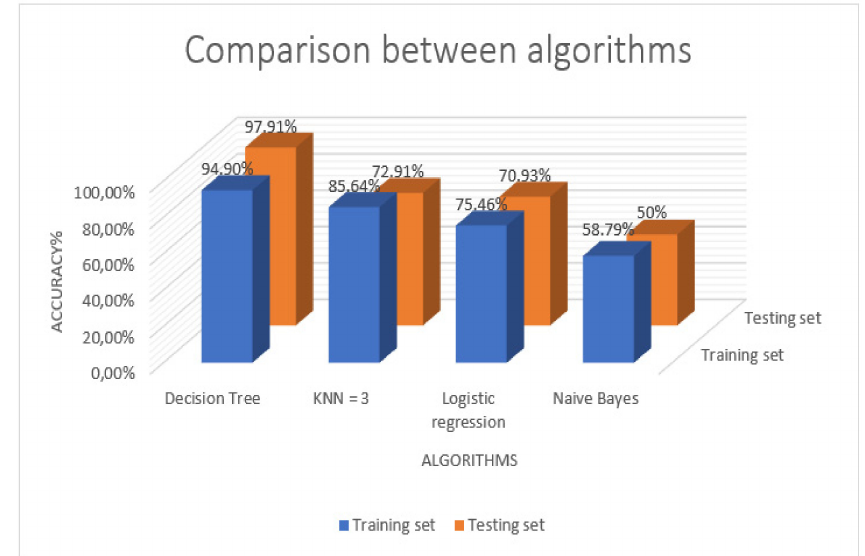
Figure 3. Comparison between machine learning